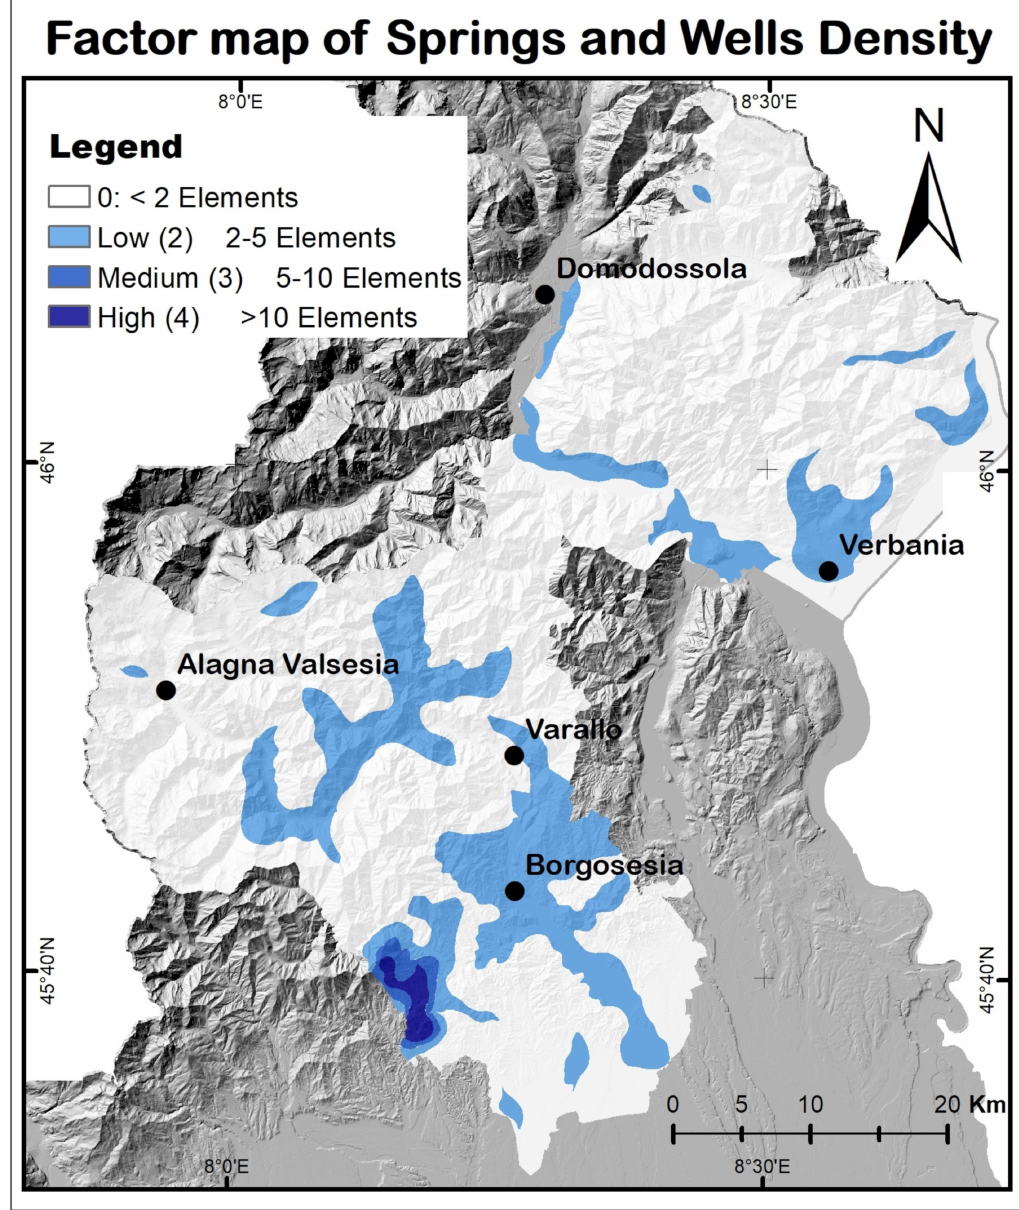
Figure 8. Factor map of springs and wells density